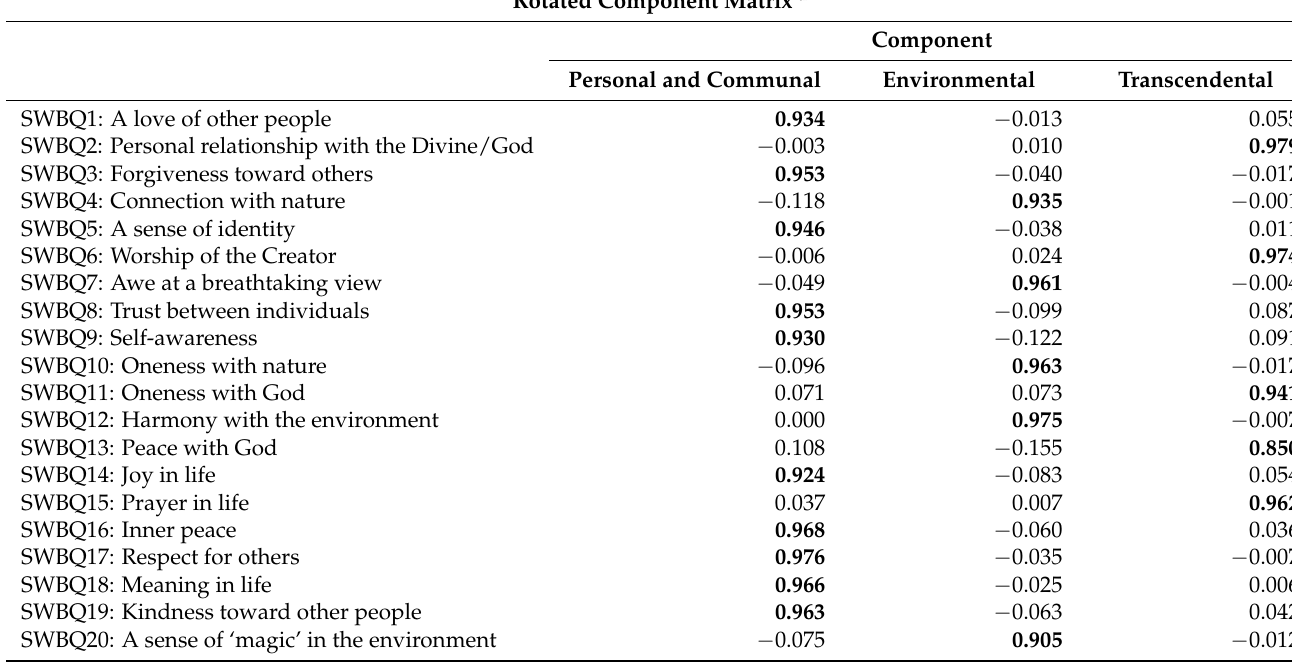
Table 1. Results of exploratory factor analysis of the Spiritual Well-being Questionnaire items (SWBQ) (N = 427). Rotated Component Matrix a Component Personal and Communal Environmental